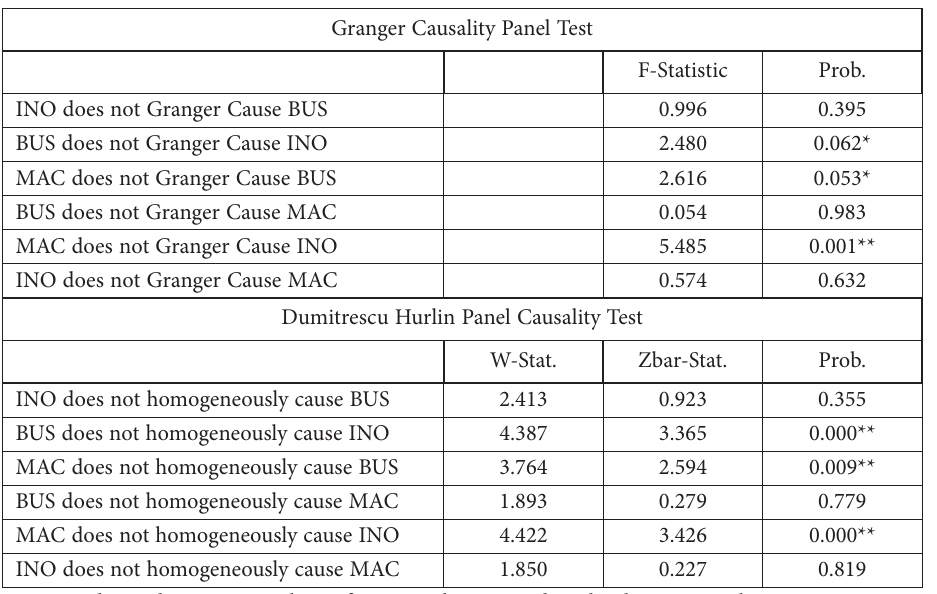
Table 5. Panel Causality Tests (source: author’s calculations) Granger Causality Panel Test